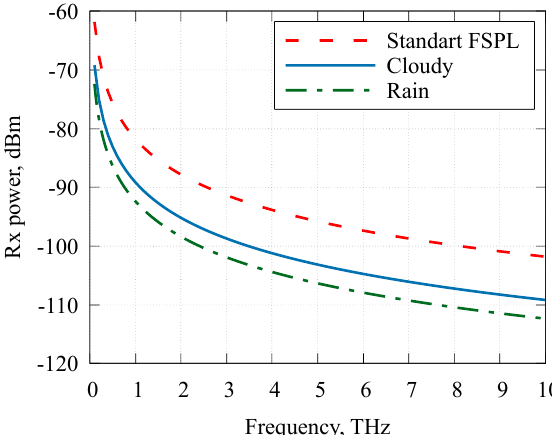
Figure 5. The difference between the proposed model accounting for both atmospheric absorption and attenuation by clouds and the standard free-space propagation model.